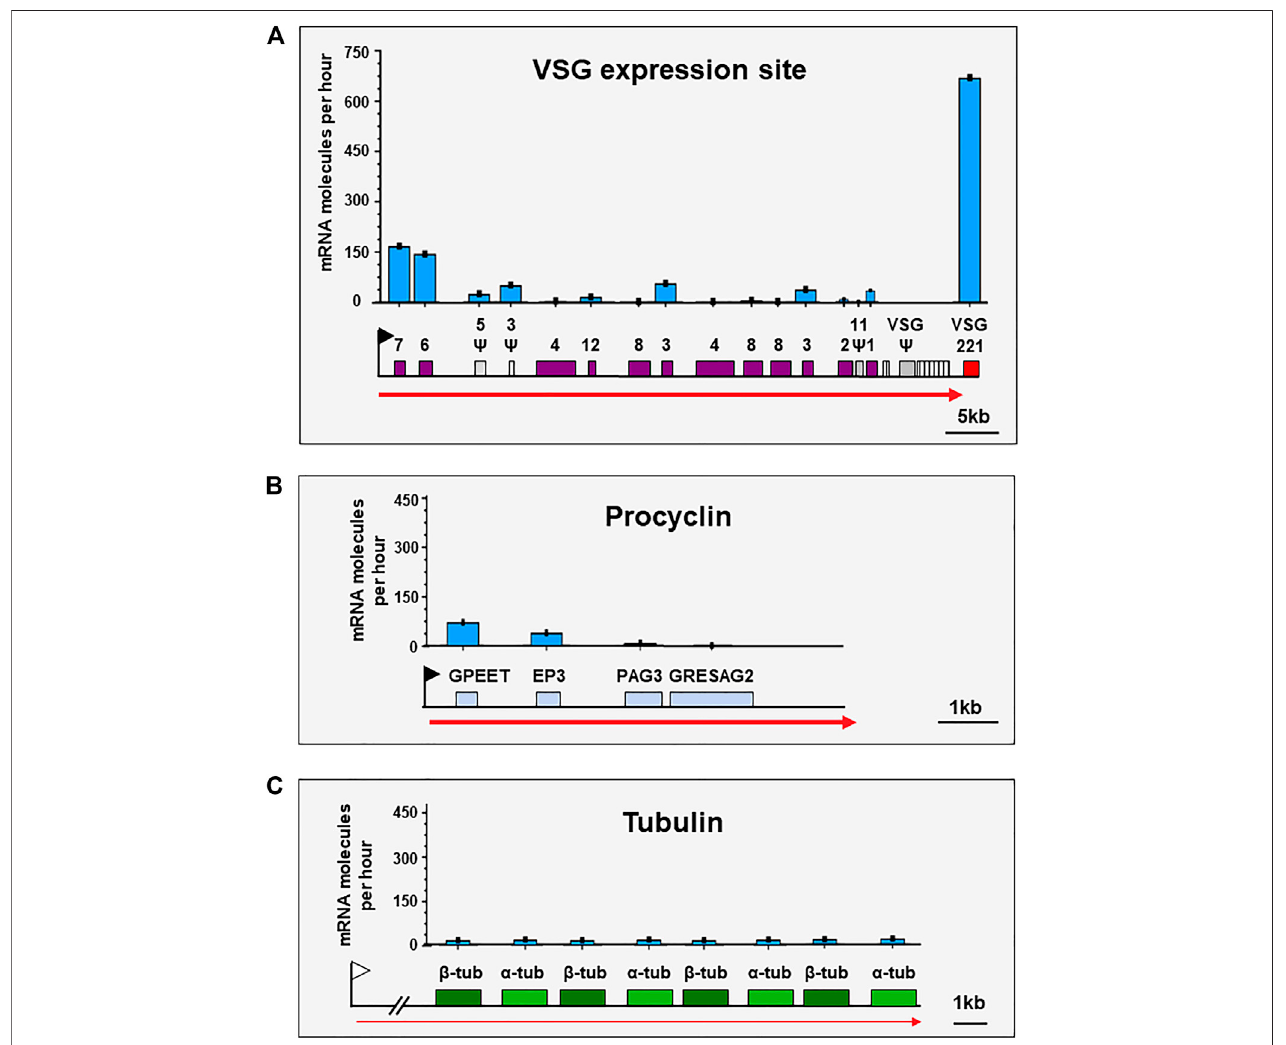
FIGURE2| VSG isthemRNA generatedat thehighestrateinbloodstreamform T.brucei .Schematicsshow theestimated number ofmRNA molecules produced per hour from genes in different genomic loci in bloodstream form Trypanosoma brucei . (A) Schematic of an active VSG expression site containing the most abundant mRNA expressed inbloodstreamform T. brucei ;VSG.ThePolIESpromoterisindicated withablack fl ag,and high amounts ofPolItranscription withathickred arrow. Expression Site Associated Genes ( ESAG s) and VSG221 are indicated with coloured boxes, pseudogenes with Ψ (grey boxes), and 70 bp repeats with striped boxes. (B) Schematic showing one of the four procyclin loci, which contain the most abundant mRNAs expressed in procyclic form T. brucei . The Pol I promoter is indicated with a black fl ag, high levels of Pol I transcription with a thick red arrow, and relevant genes with coloured boxes. (C) Schematic of the tubulin locus, which containsthemostabundantmRNAstranscribedbyPolIIin T.brucei .TheupstreamPolIIpromoterisindicatedwithawhite fl ag,andlowlevelsofPolIItranscription with athin red arrow. Three pairs ofalternating α -tubulin and ß -tubulin genes(out ofatotal ofeight perlocus)areindicatedwithcoloured boxes.Forall graphs, the y -axes are the same scale as in panel (A) . Values for mRNA molecules generated per hour were derived from Supplementary Tables 1, 2 in Budzak et al. (2022).